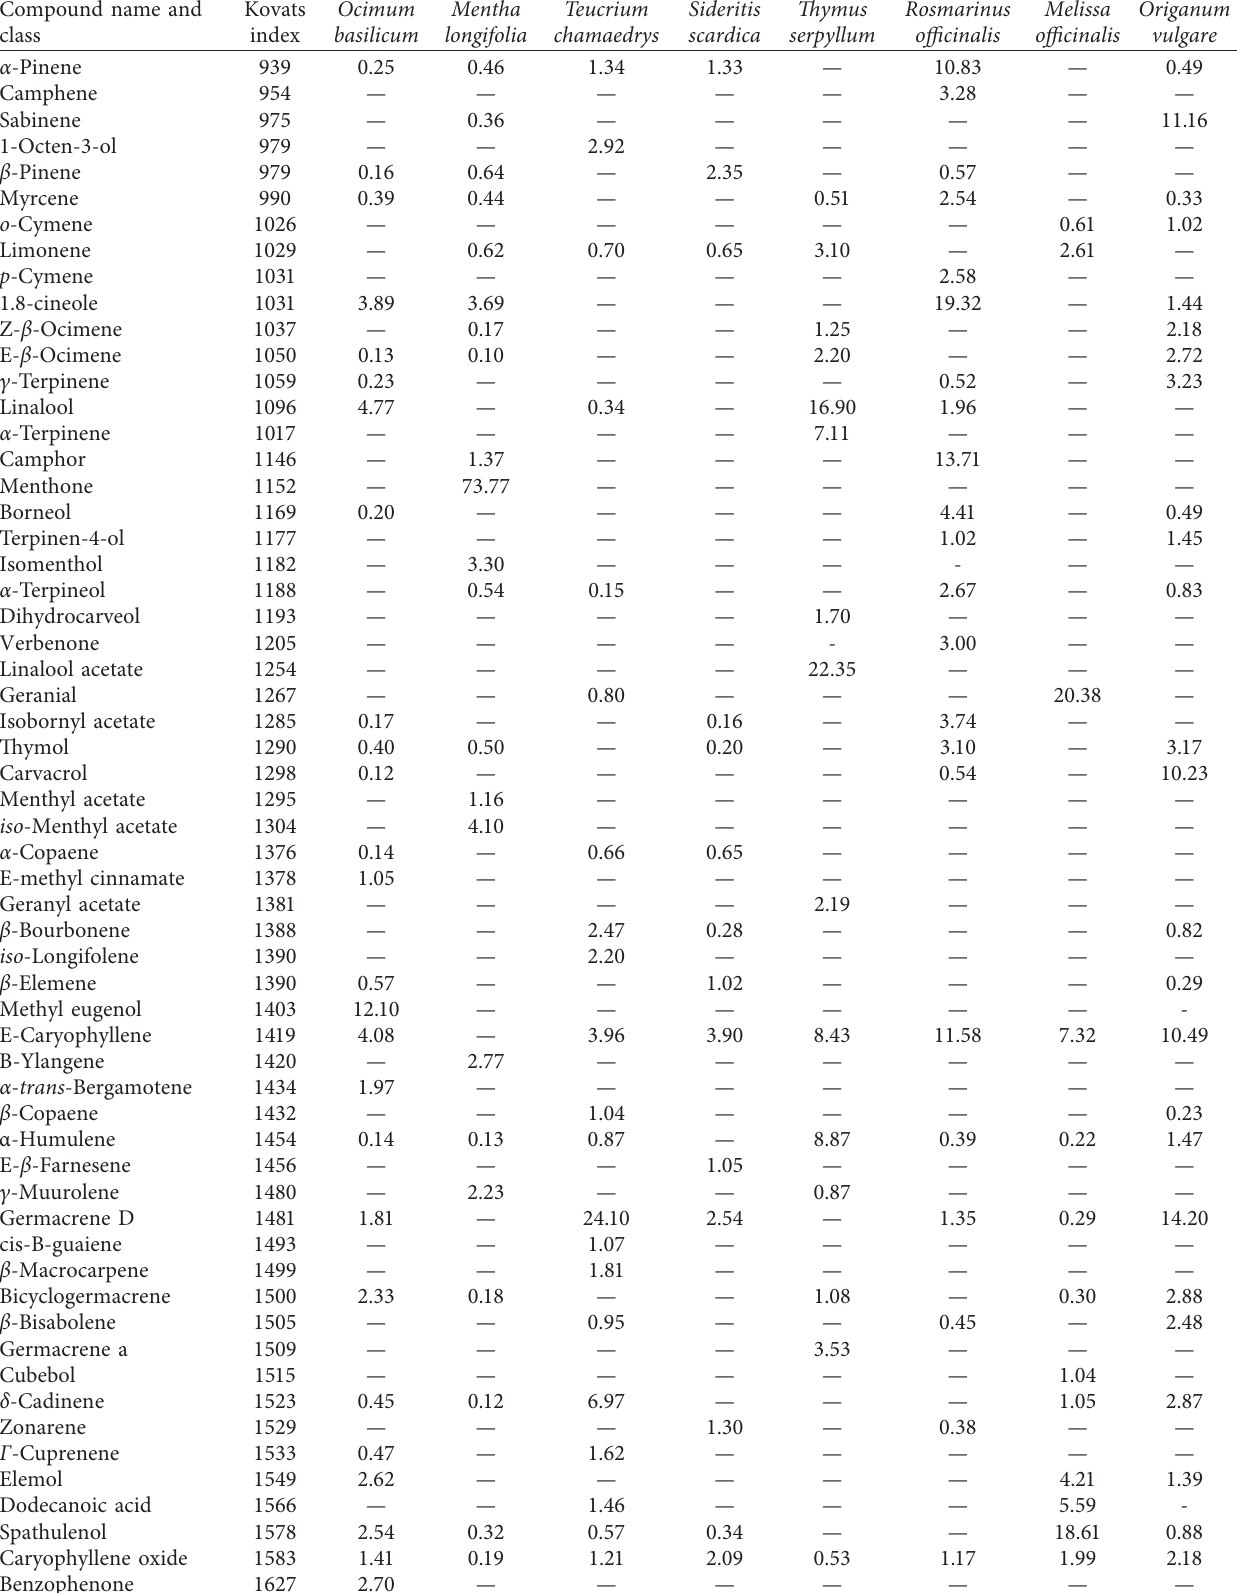
Table 1: Phytochemical analysis of essential oils obtained from the extracts of plants used as teas, belonging to the Lamiaceae family. Compound name